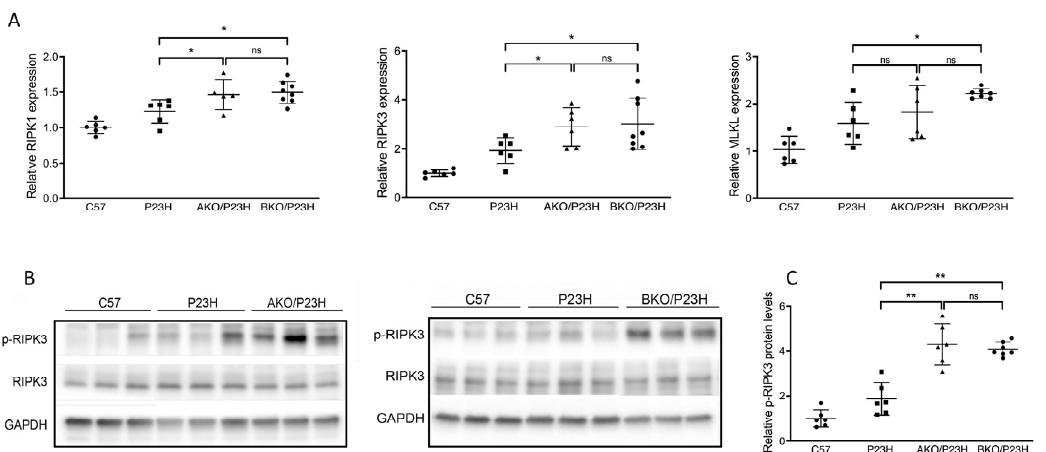
Figure 4. Increase in activation of necroptosis pathway in the photoreceptors of AKO/P23H and BKO/P23H mice. ( A ) Quantification of transcript levels of RIPK3, RIPK1, MLKL in retinas of AKO/P23H, BKO/P23H and P23H mice at two months of age, normalized to levels in the retinas of wild-type C57 mice. ( B ) Representative western blots from retinas of AKO/P23H, BKO/P23H, P23H and C57 mice probed for p -RIPK3, RIPK3 and GAPDH. ( C ) Quantification of western-blot bands of p -RIPK3 normalized to GAPDH (n = 6), * p < 0.05; ** p < 0.01; ns, not significant. One-way